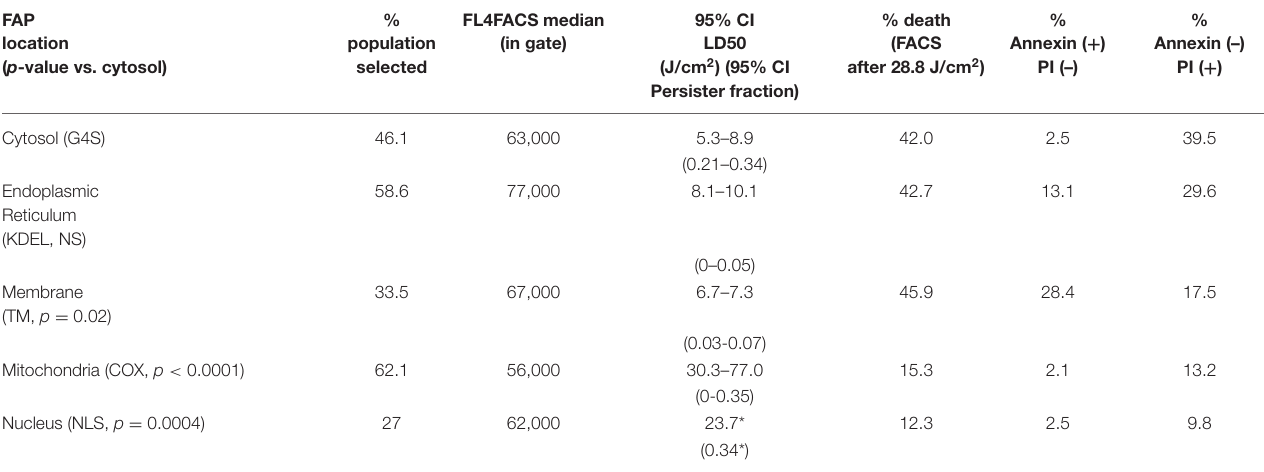
TABLE 2 | Fraction of cells sorted, median fluorescence intensity in selection gate, half-maximal lethal doses (LD50) by MTS assay, and death staining Annexin/PI positive populations for each FAP-localized cell line after illumination. FAP